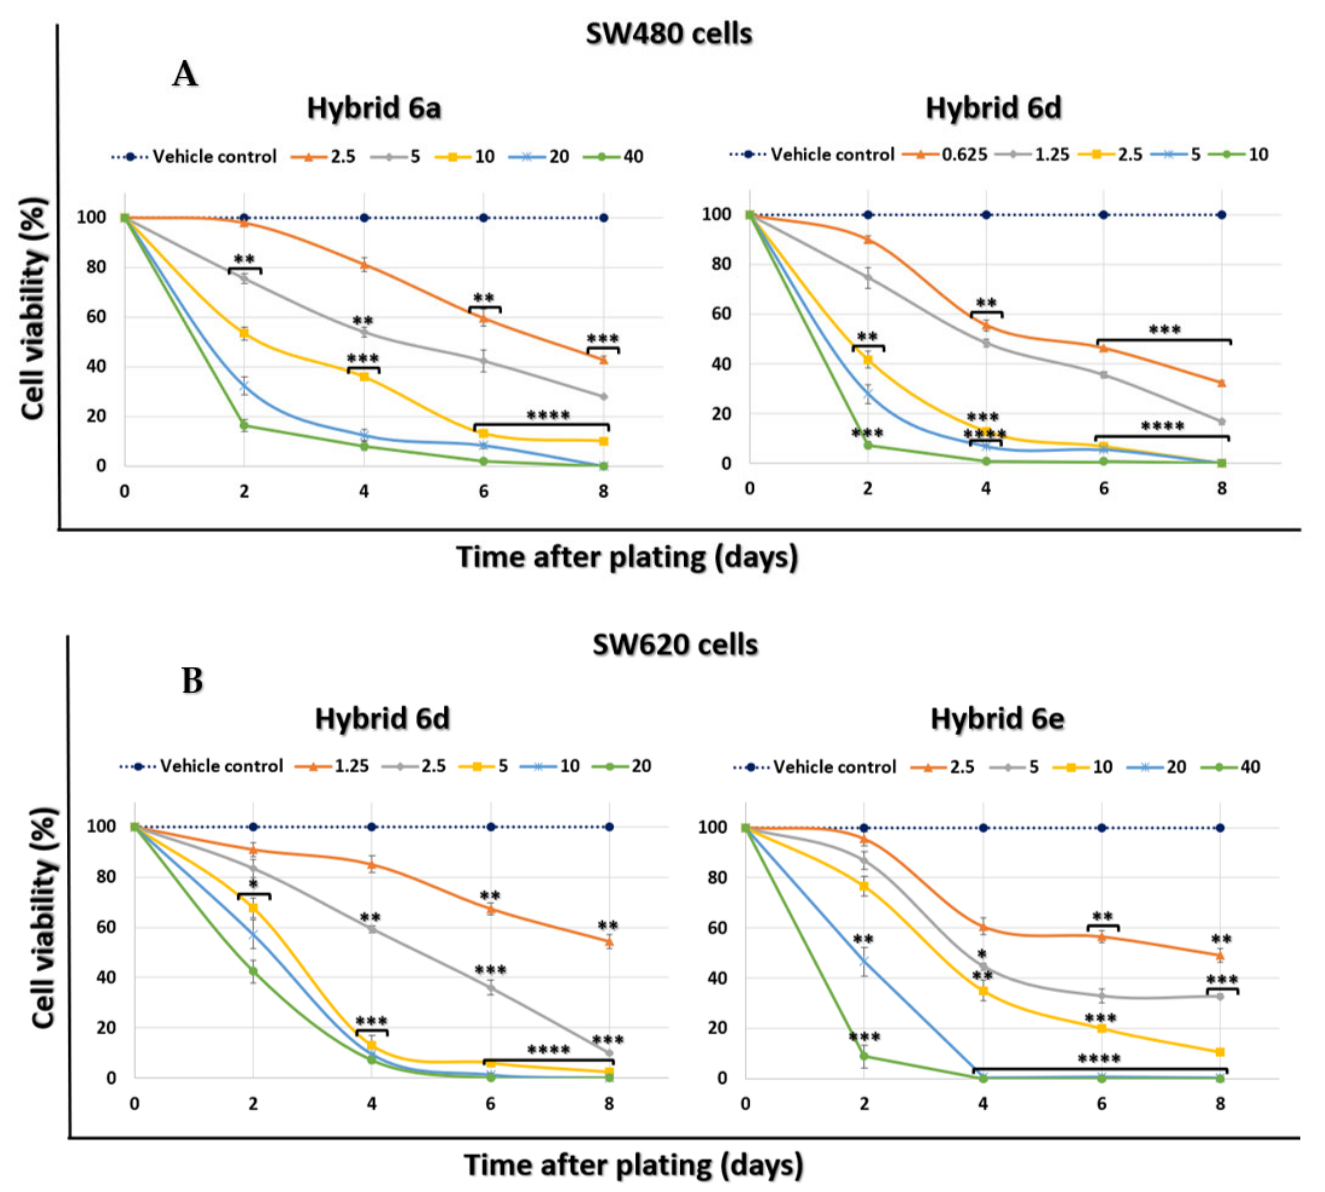
Figure 5. ( A ). Antiproliferative activity of hybrids 6a and 6d in SW480 cells; ( B ). Antiproliferative activity of hybrids 6d and 6e in SW620 cells. Data are presented as the mean ± SE of three independent experiments. (* p < 0.05; ** p < 0.01; *** p < 0.001; **** p < 0.0001). Vehicle control was assumed to be 100% viable. Table 3. Data of viability (%) at the lowest and the highest concentrations evaluated.